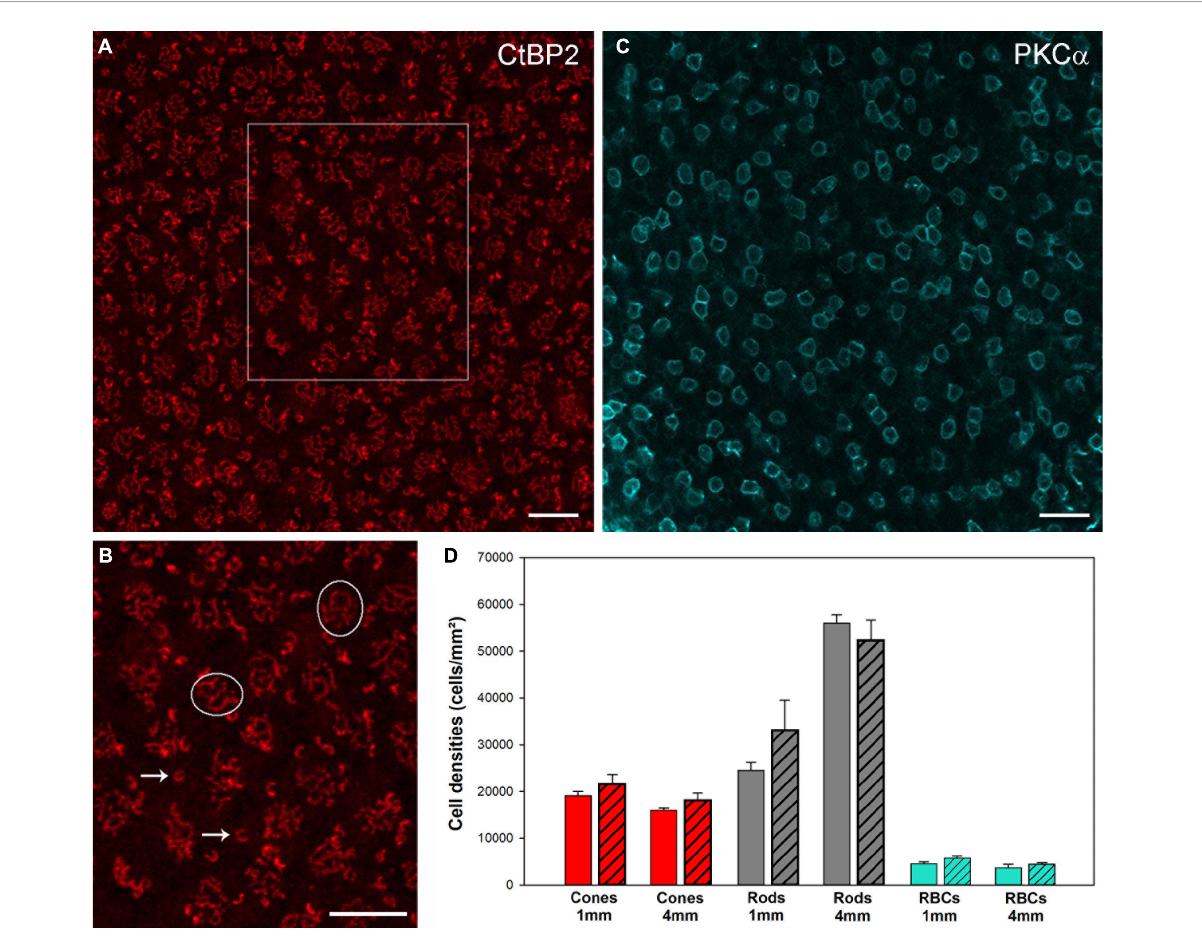
FIGURE4 CtBP2 und PKC α immunostaining to quantify photoreceptor and rod bipolar cell densities in whole mount preparations. (A) CtBP2 labeling in a square of 100 × 100 µ m at 4 mm temporal of a 13-year-old animal. (B) High-resolution image of the frame in (A) . (C) PKC α labeling in a square of 200 × 200 µ m at 4 mm temporal in a 12-year-old animal. For the cones, we counted the cone pedicles that were seen as clusters of CtPB2-labeled synaptic ribbons (circles). For the rods, we counted the single horseshoe-shaped synaptic ribbons (arrows) seen outside or above the cone ribbon clusters, as it is known that each single ribbon represents one rod synaptic ending. For the rod bipolar cells, we counted the number of PKC α -labeled somata in the INL. Scale bars, (A,B) 10 µ m and (C) 20 µ m. (D) Comparison of cell densities for cones (red), rods (gray) and RBCs (cyan) from control and aged animals (patterned bars) at 1 and 4 mm temporal locations. Data are presented as mean ± SEM. No significant differences were found for pairwise comparisons between control and aged animals, respectively (pairwise t -tests, p > 0.05).